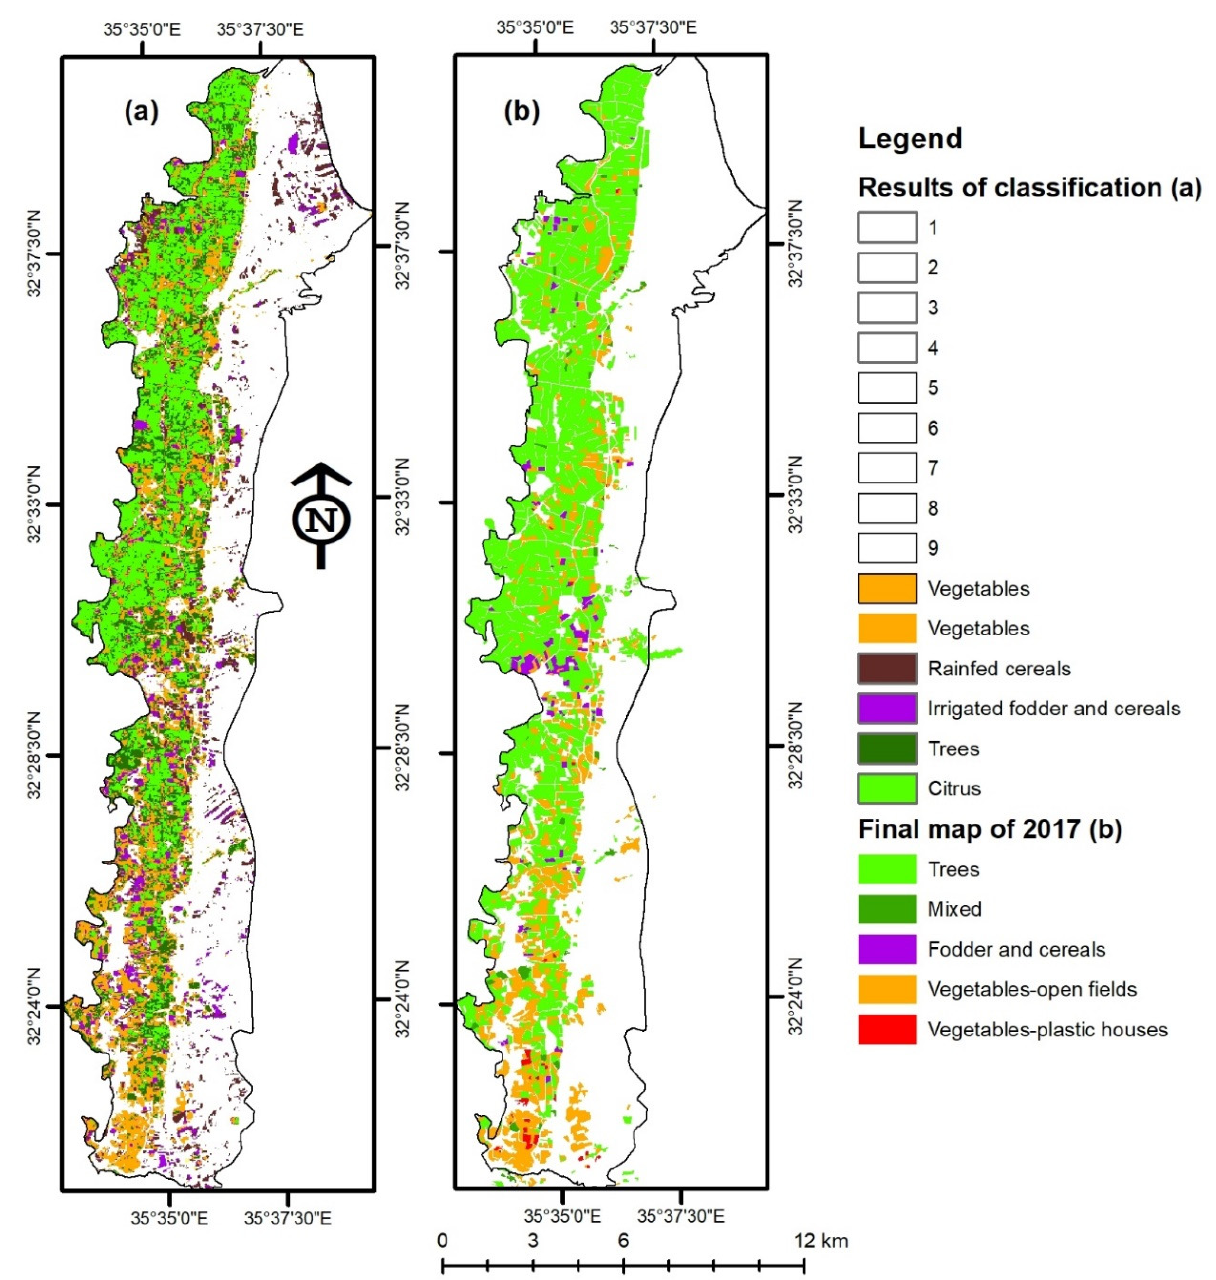
Figure 3. Results of unsupervised classification of the multi-temporal NDVI layers ( a ) and the final map of irrigated crops ( b ) for NJV in 2017.